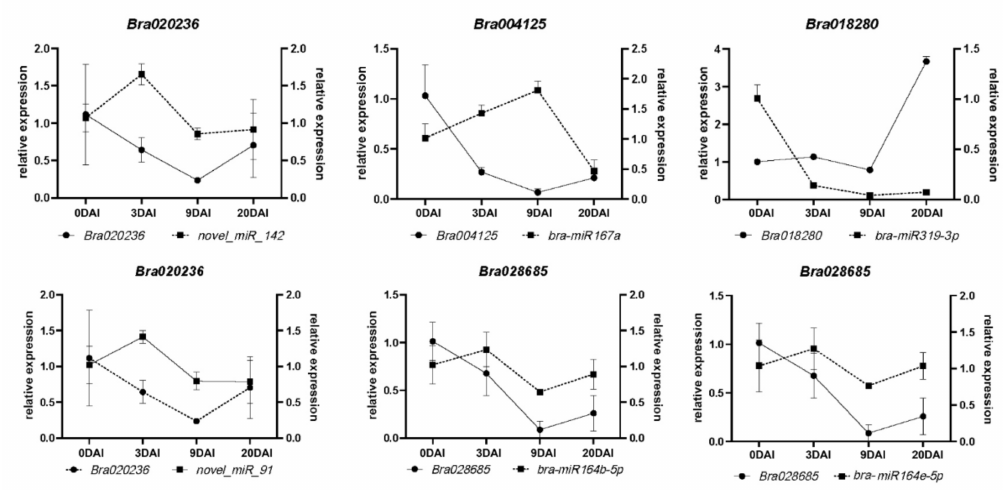
Figure 6. qRT-PCR validation of miRNAs and their targeted gene expression at different development periods of the S-line after inoculation. The dotted and solid lines are expressed miRNAs and targeted genes,